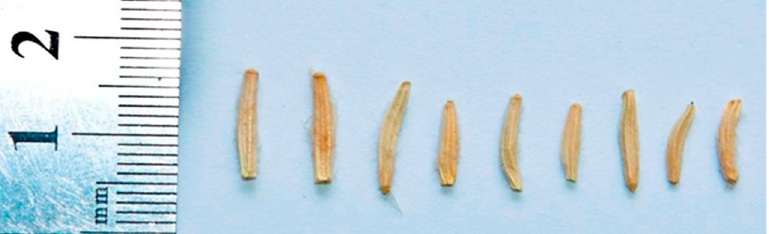
Figure 2. Mature S. tau-saghyz